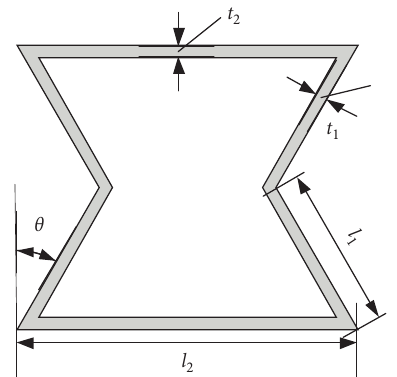
Figure 4: The unit cell of concave hexagonal honeycomb